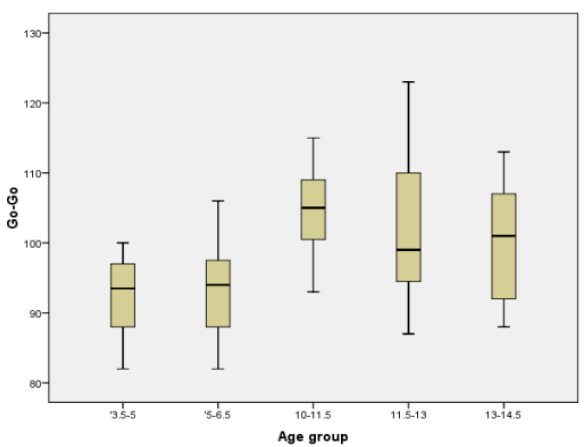
Figure 6. Boxplot for Go-Go values.